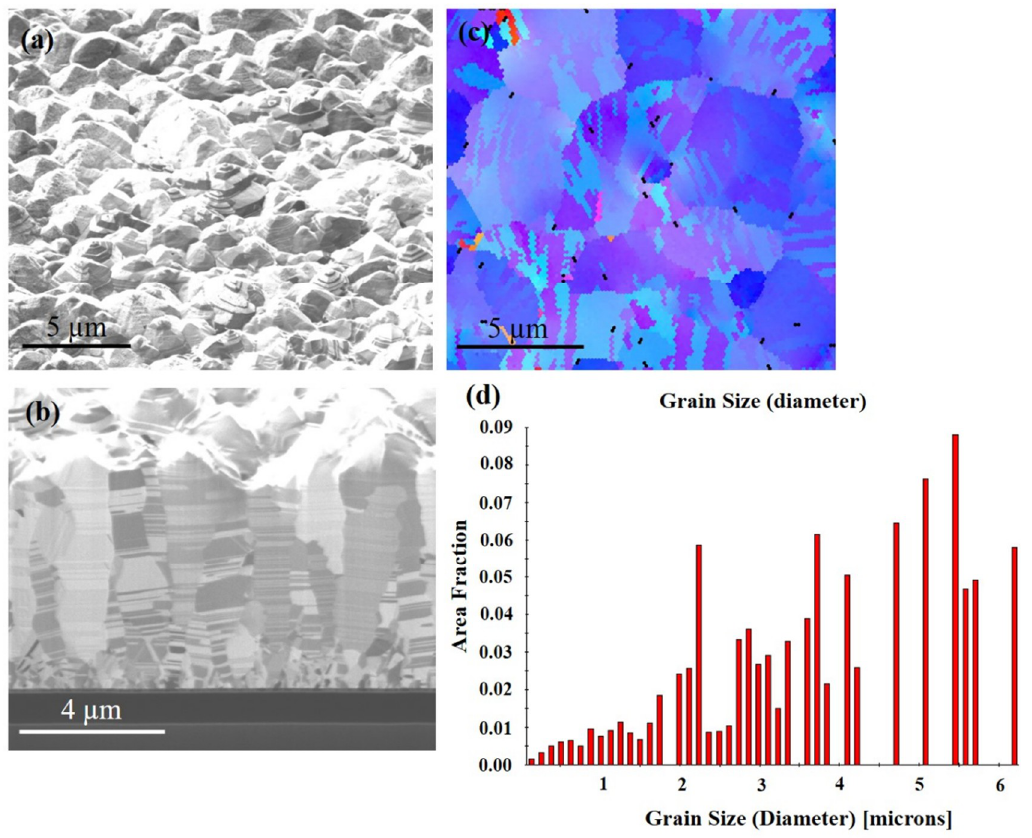
Figure 1. FIB micrographs of as-deposited Cu film. ( a ) Top surface. ( b ) Cross section. ( c ) Plan-view of the inverse pole figure map from electron backscatter diffraction (EBSD) of the sample at initial state. ( d ) Grain size distribution of the grains in pole Figure 1c.